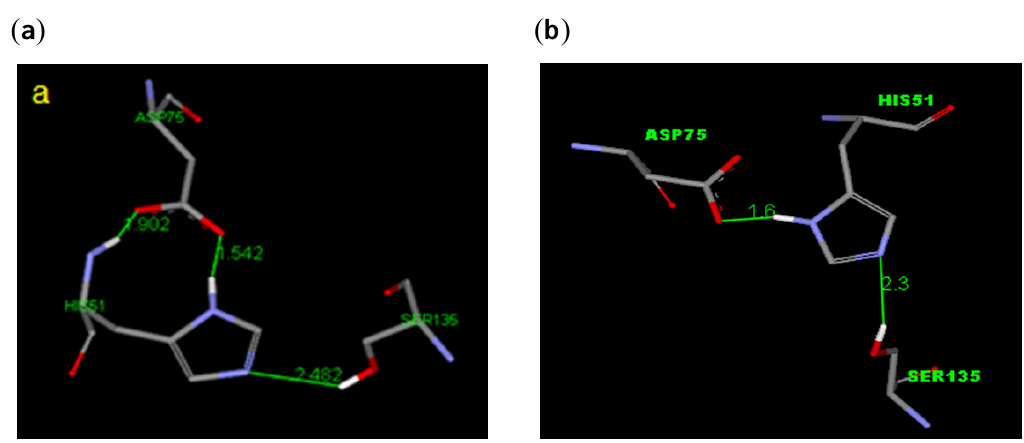
Figure 1. The spatial arrangement of the catalytic triad of ( a ) DEN2 NS2B/NS3 (2FOM. Pdb); ( b ) previous homology modeling [10].